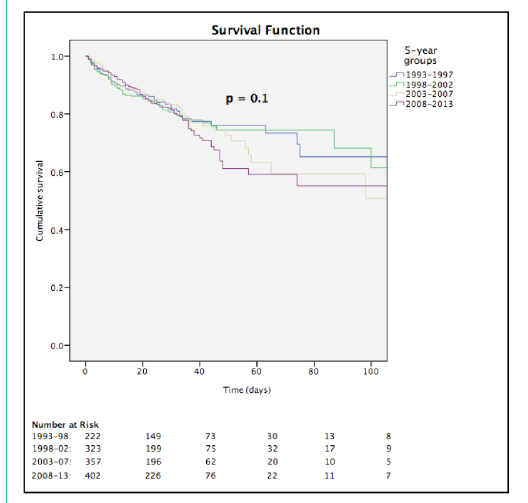
Figure 2: Five-year stratification of all-cause in-hospital mortality.